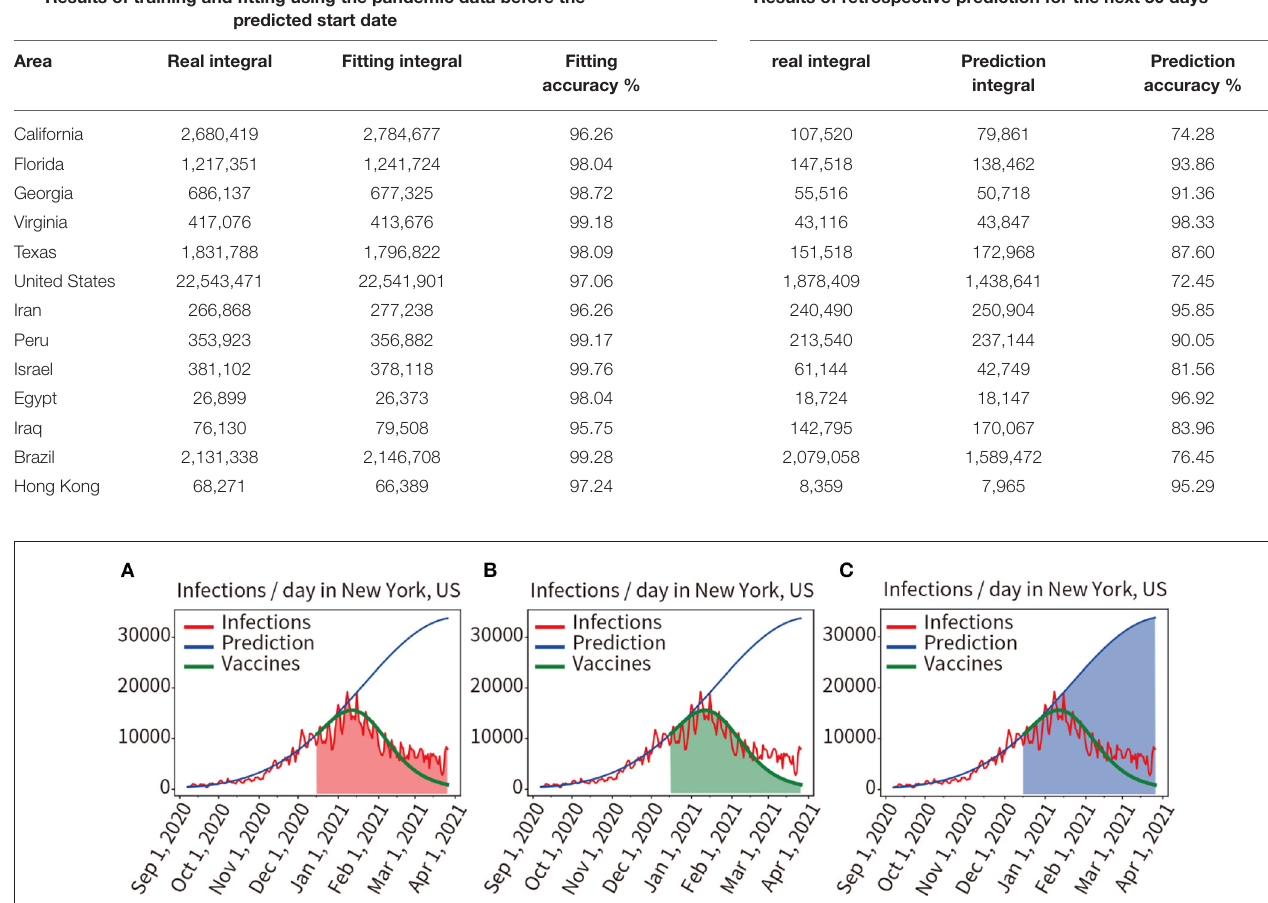
Results of retrospective prediction for the next 30 days